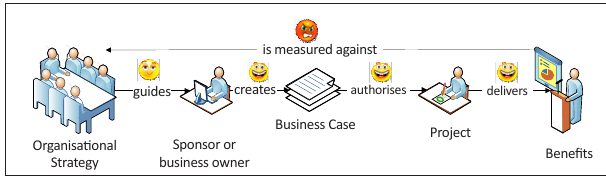
FIGURE 7: Actual business case information flow measured against theoretical